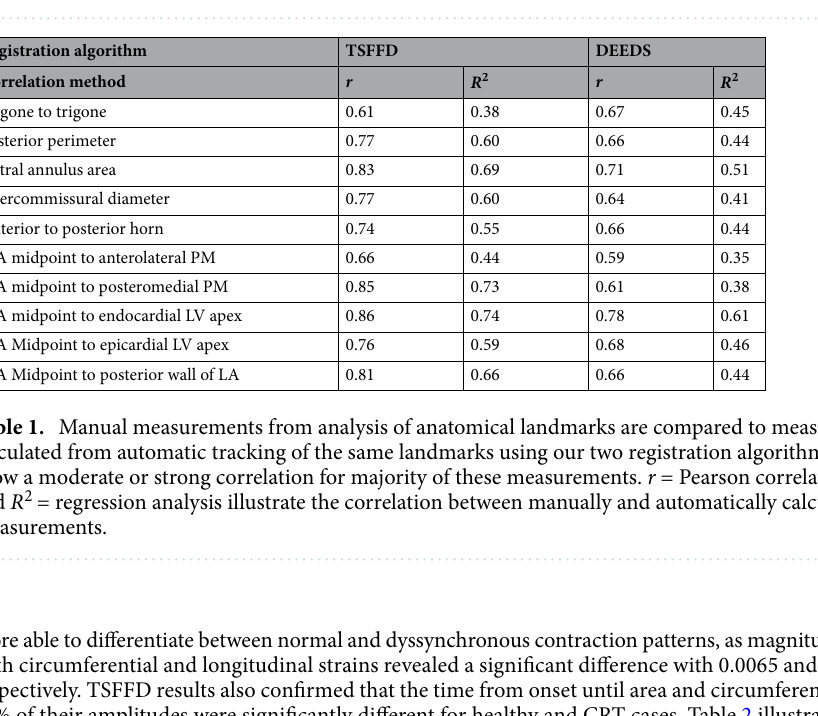
Figure 5. DEEDS tracking error, where X axis is the validation set. Y axis displays the error calculated in percentage. Each box plot represents the error in percentage from all the 500 measurements throughout the cardiac cycle. Mean intra-observer error across all sets is illustrated as a shaded region.